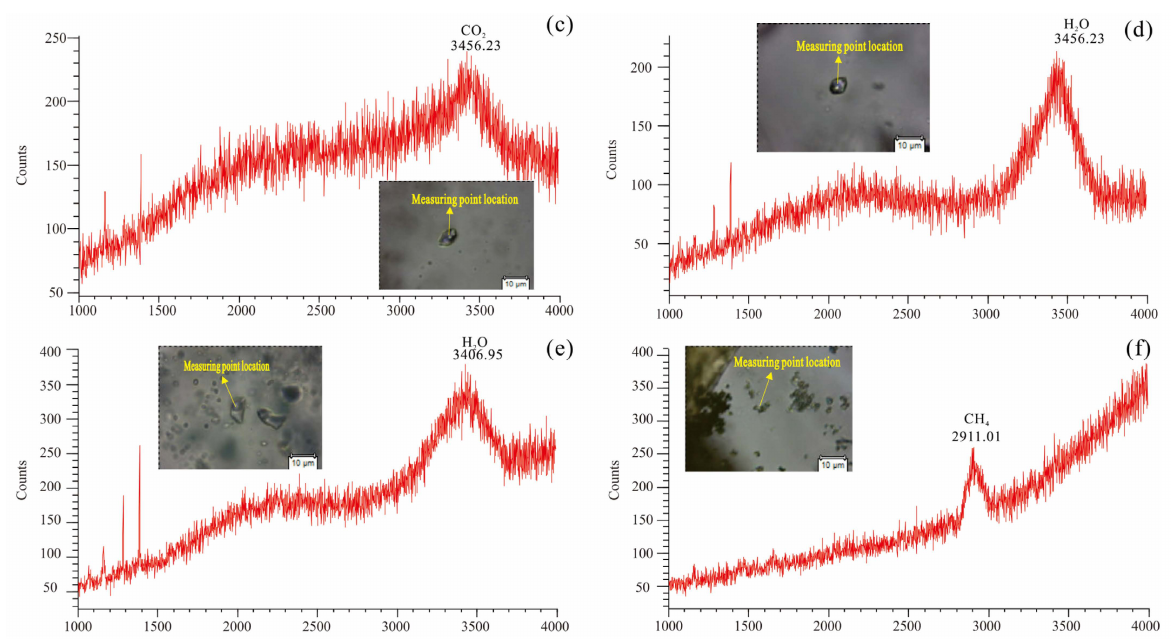
Figure 7. Laser Raman spectra for fluid inclusions representative of the various types described from Xiawolong gold deposit. ( a , b ) Type 1 aqueous inclusions, ( c – e ) type 2 H 2 O–CO 2 inclusions, and ( f ) type 4 CO 2 .